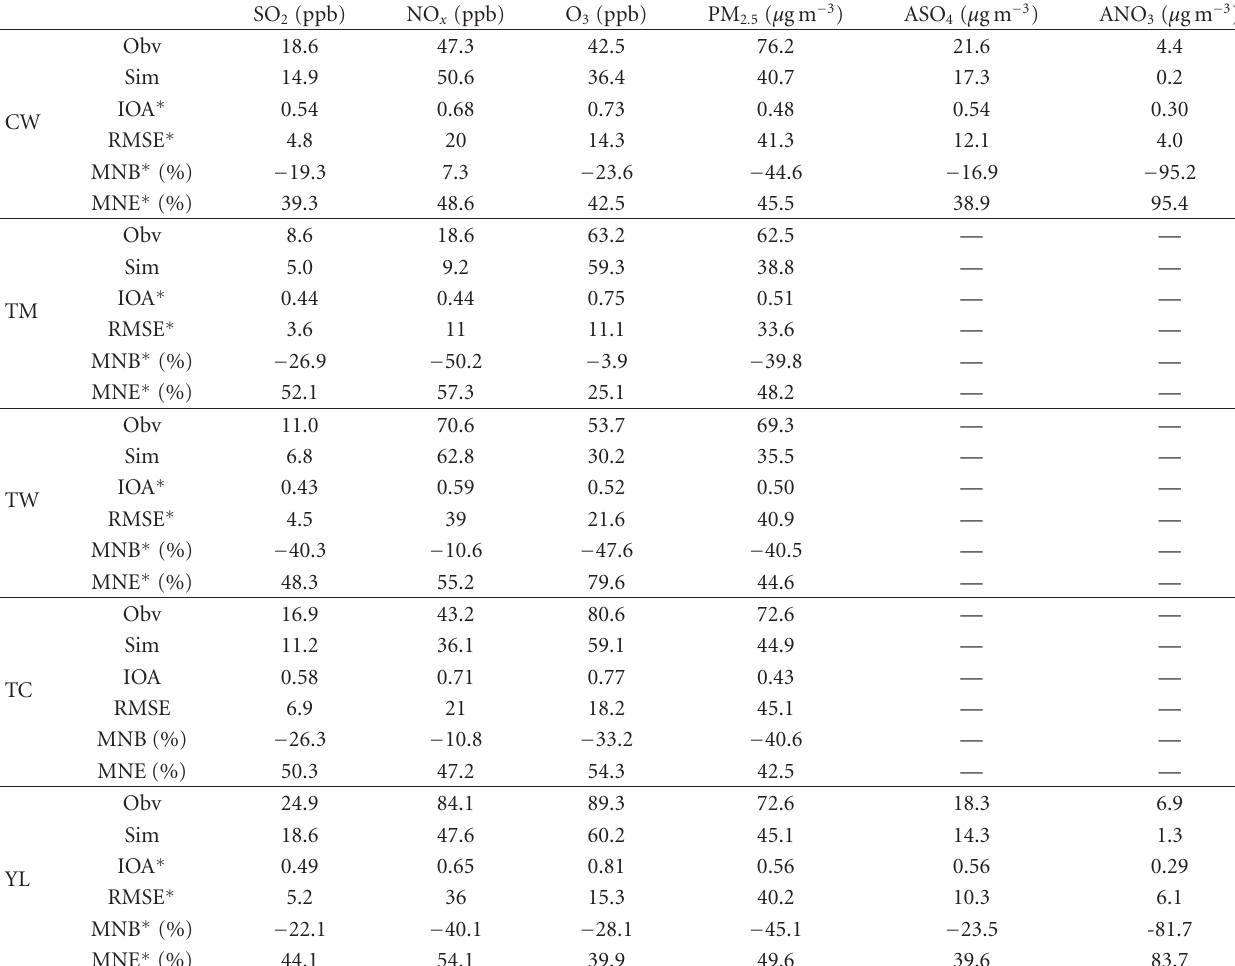
Table 2: Model performance of gaseous pollutant and particulate matter simulation over Hong Kong in October 2004 for case